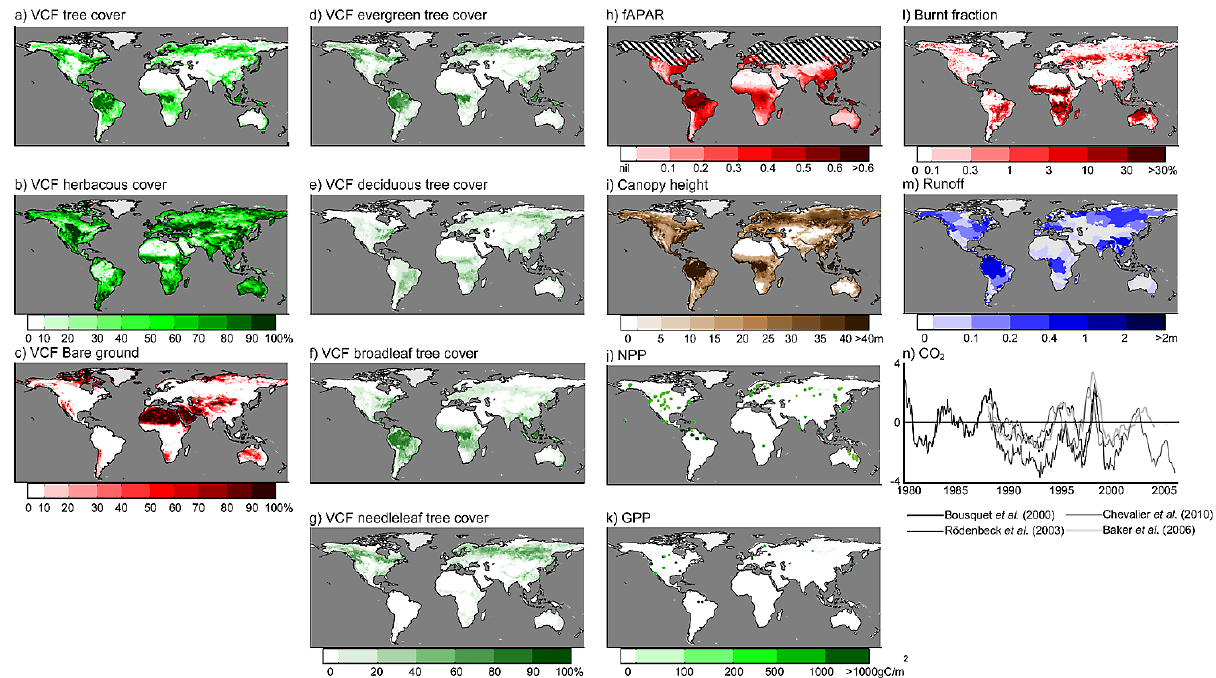
Fig. 1. Illustration of the benchmark datasets: ISLSCP II continuous vegetation fields based on a snapshot for 1992–1993 (DeFries and Hansen, 2009) give the proportions of (a) woody vegetation > 5m in height (tree), (b) grass/herb and woody vegetation < 5m (herbaceous), and (c) bare ground; for areas with tree cover, the datasets also give the proportion of (d) evergreen, (e) deciduous, (f) broadleaf and (g) needleleaf; (i) annual average fAPAR value for 1998–2005 from SeaWiFS (Gobron et al., 2006); (j) annual average burnt fraction for 1997– 2006 from the GFED3 dataset (Giglio et al., 2010); (k) sites with measurements of net primary production, NPP and (l) measurements of gross primary production, GPP are both from the Luyssaert et al. (2007) dataset; (m) global atmospheric CO 2 concentrations for 1980–2005 based on inversion datasets (Bousquet et al., 2000; R¨odenbeck et al., 2003; Baker et al., 2006; Chevalier et al., 2010); (n) annual average river runoff from 1950–2005 from the Dai et al. (2009) dataset, displayed over associated GRDC basins (http://www.bafg.de/GRDC); and (m) vegetation height based on a snapshot from 2005 (Simard et al., 2011). Hashed area in (g) shows areas without comparison